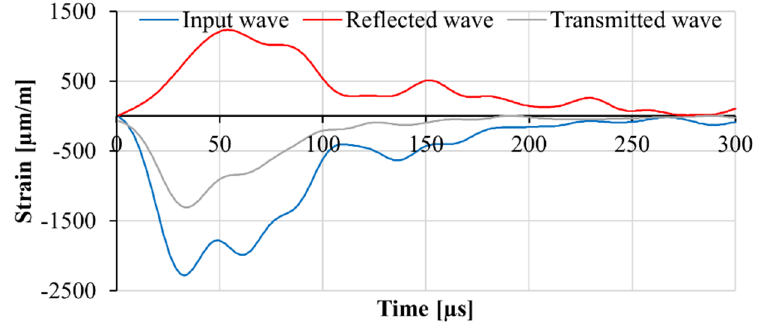
Figure 2. An example of the recorded input, reflected, and transmitted waves in the SHPB.